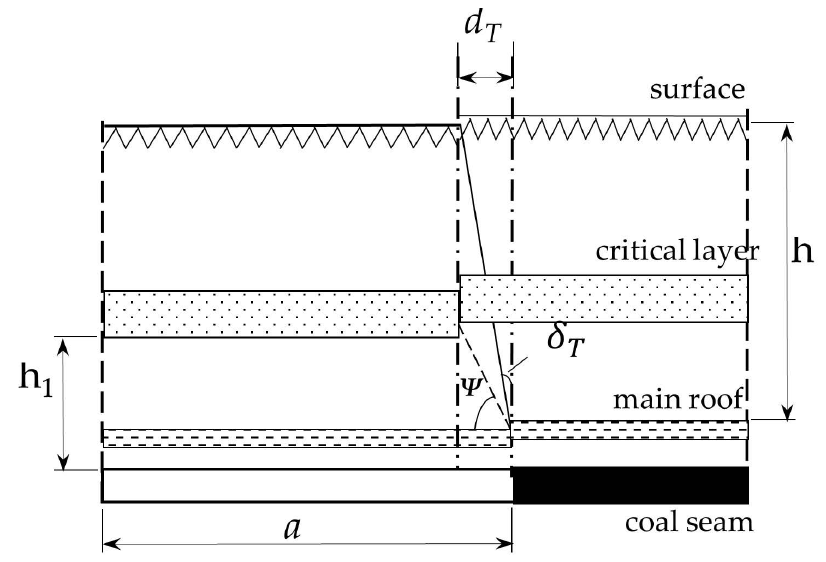
Figure 14. Comparison of upper and lower wells with collapsed fractured wells.